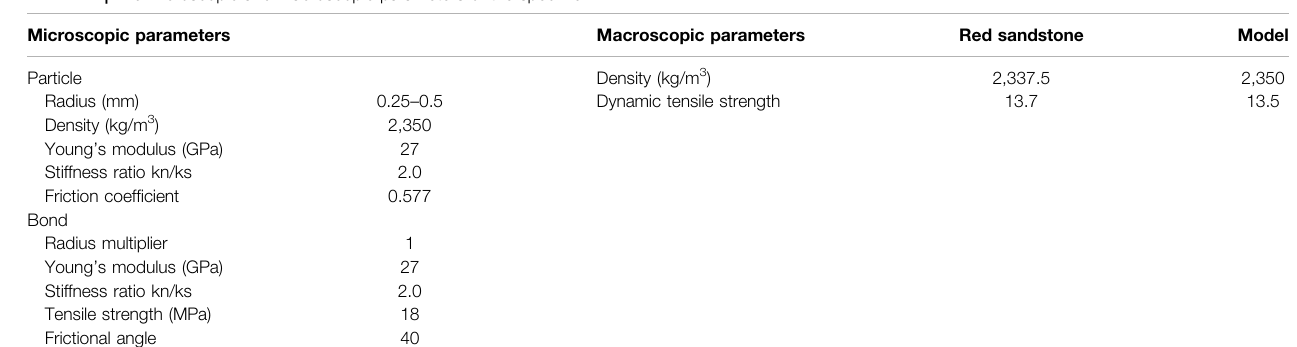
TABLE 2 | The microscopic and macroscopic parameters of the specimen. Microscopic parameters